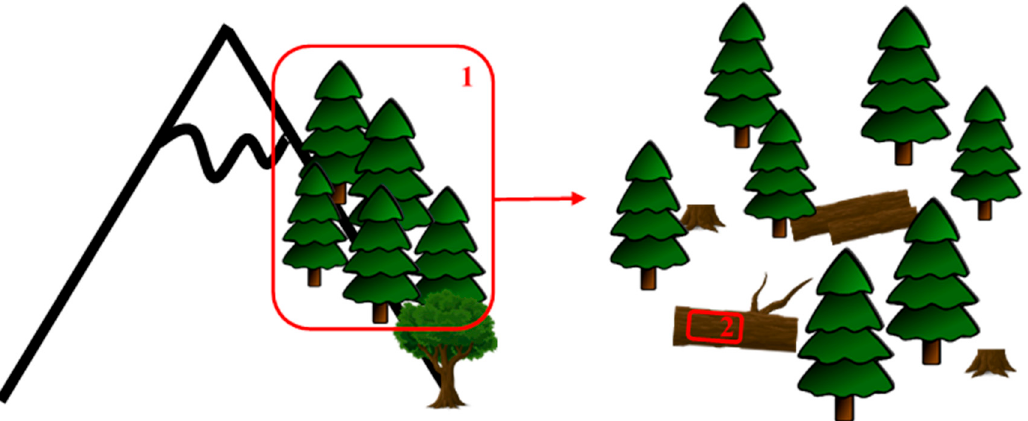
Figure 7. Representation of the two spatial scales used in the study. 1: Habitat (500 m²). 2: Microhabitat (300 cm²).